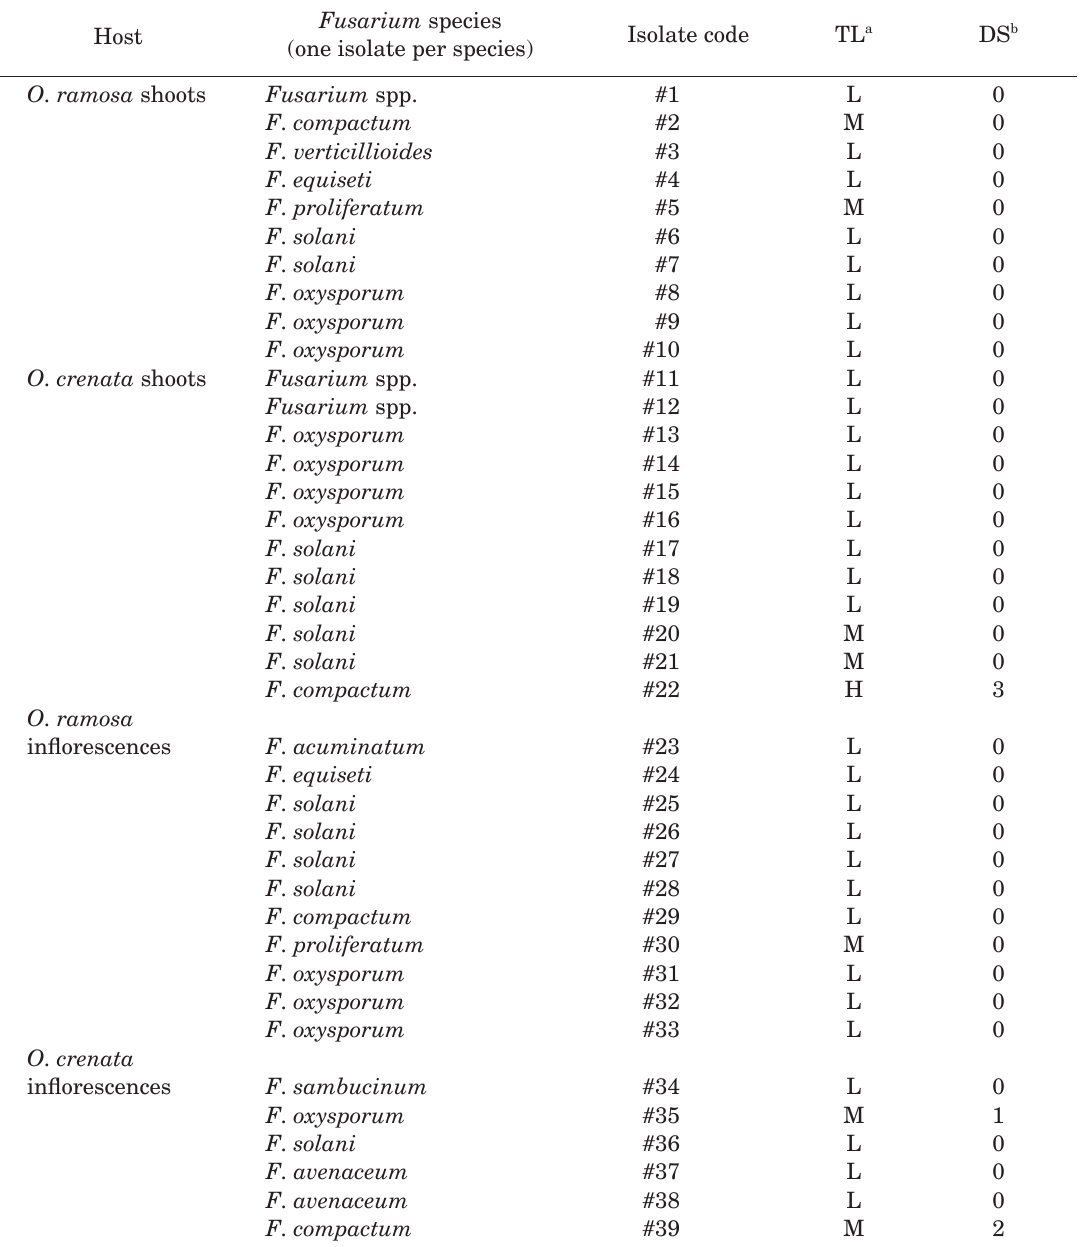
Table 1. Toxicity levels (TL) of Fusarium culture filtrates on the seed germination of bean broomrape ( Orobanche crenata ), and disease severity (DS) of Fusarium isolates on O. crenata in an experiment conducted in pots under greenhouse conditions. One-way ANOVA showed a highly significant difference between the 39 isolates (F=92.2, P